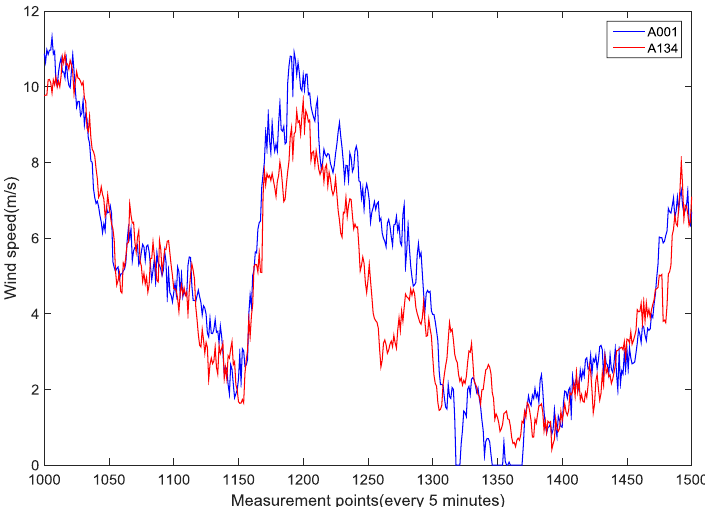
Figure 8. Wind speed series in time of wind turbines A001 and A134 in a certain period in the Qiaodong II wind farm.